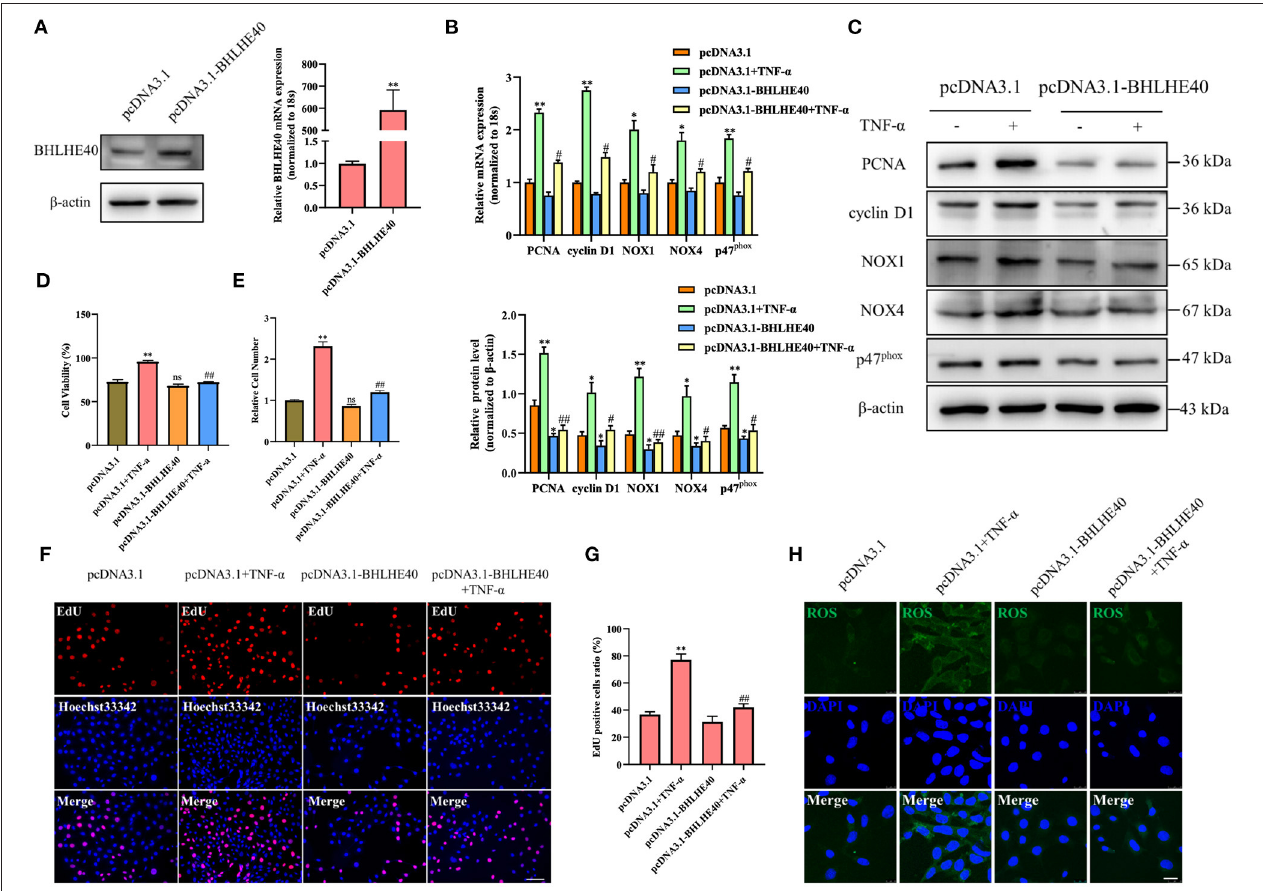
FIGURE 5 | Overexpression of BHLHE40 inhibits TNF- α -induced proliferation and oxidative stress in VSMC. (A) VSMCs were transfected with pcDNA3.1-BHLHE40, and the expression of BHLHE40 was detected by Western blotting and qRT-PCR. ** p < 0.01 vs. pcDNA3.1 group. (B–H) VSMCs were transfected with pcDNA3.1-BHLHE40 and then treated or not with TNF- α for 24h. The expression of PCNA, cyclin D1, NOX1, NOX4 and p47 phox was determined by qRT-PCR (B) and Western blotting (C) . Statistic of band intensities is shown on the left. * p < 0.05 and ** p < 0.01 vs. pcDNA3.1 group, # p < 0.05 and ## p < 0.01 vs. pcDNA3.1 + TNF- α group. The cell viability was determined by MTS assay (D) , and cell counting was carried out using a Countess automated counter (E) . ** p < 0.01 vs. pcDNA3.1 group, ## p < 0.01 vs. pcDNA3.1 + TNF- α group. Cell proliferation was detected by EdU staining (F) . Scale bar = 100 µ m. Analysis of the percentage of EdU positive cells (G) . ** p < 0.01 vs. pcDNA3.1 group, ## p < 0.01 vs. pcDNA3.1 + TNF- α group. ROS levels were detected by DCFH-DA staining (H) . Scale bar = 25 µ